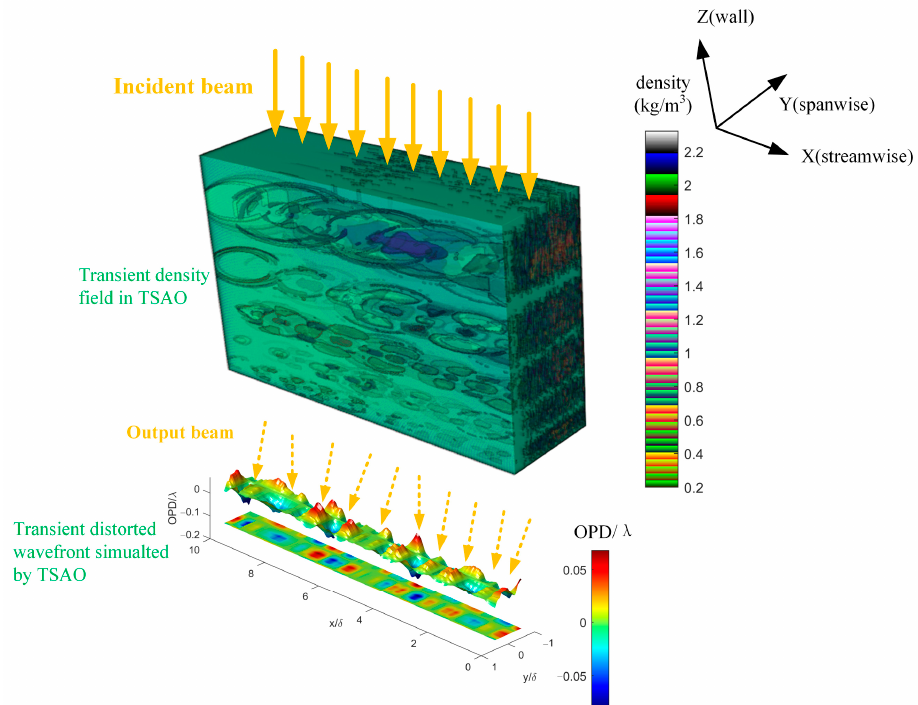
Figure 4. The configuration of the transient simulator for aero-optical effects (TSAO).